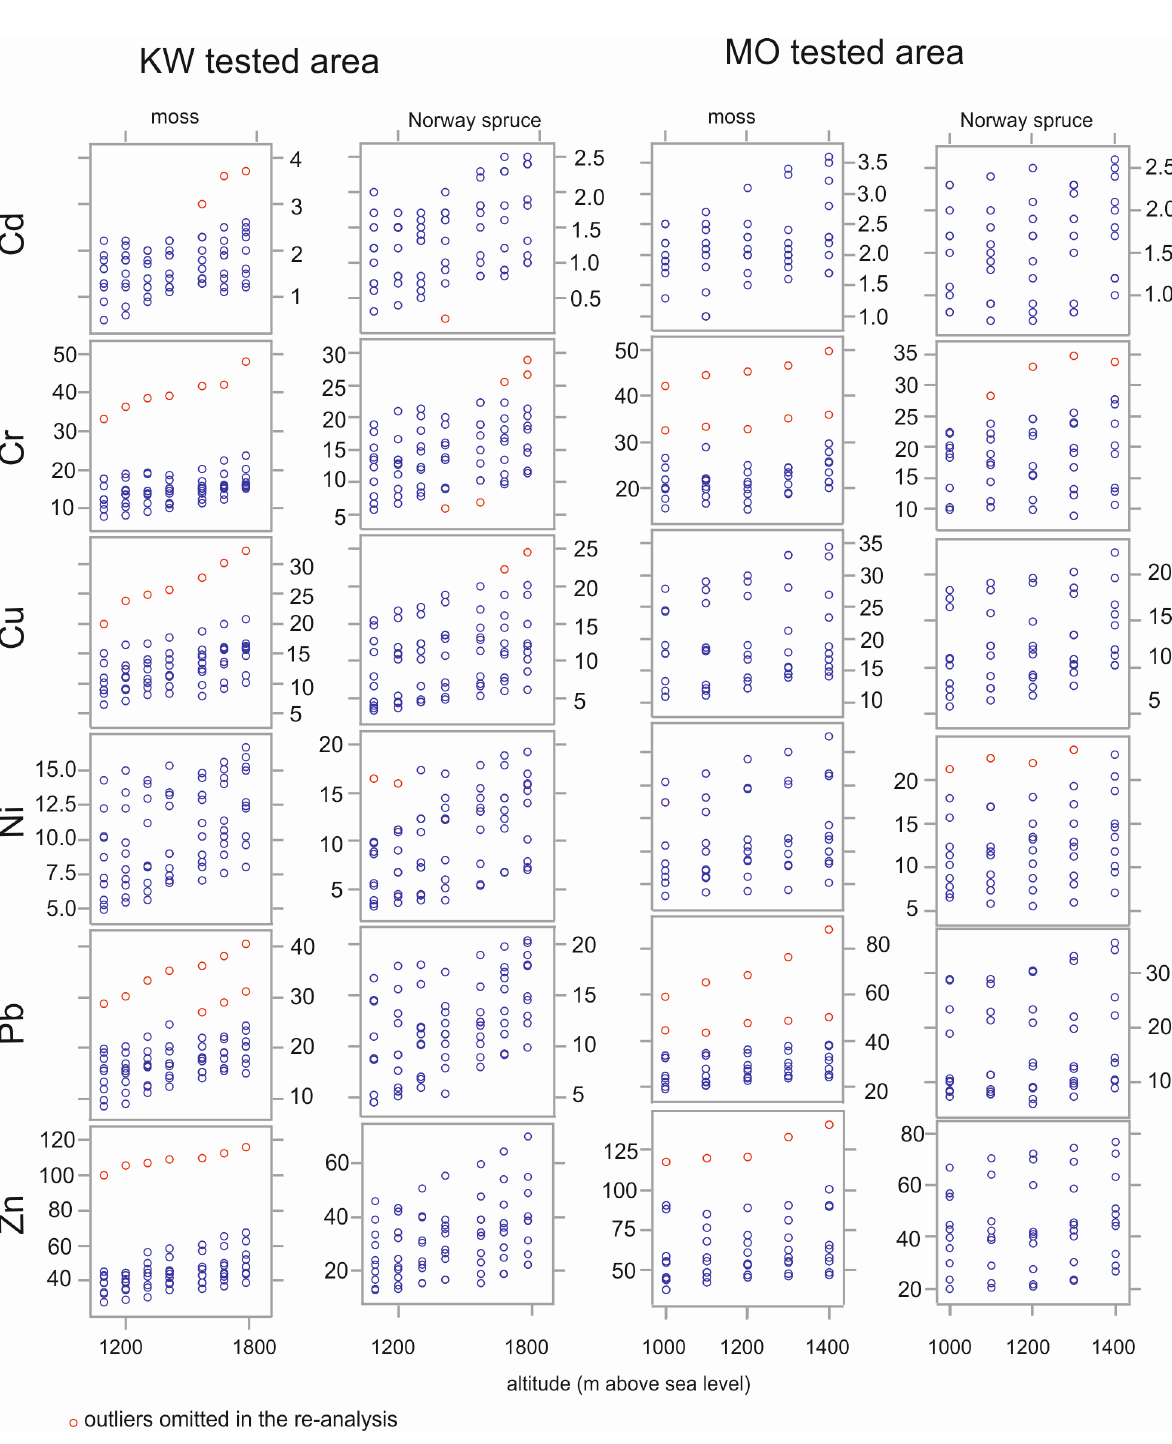
Figure 4. Dependence of heavy metal content (µg/g d.m.) in plants ( Pleurozium schreberi and Picea abies ) on the altitude, broken down into test areas (Kasprowy Wierch-KW and Morskie Oko-MO) in the Tatra National Park, Poland.